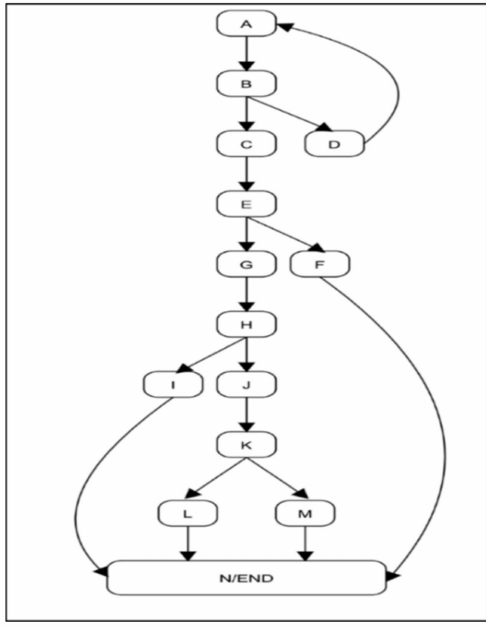
Figure 4. The activity flow graph of the test